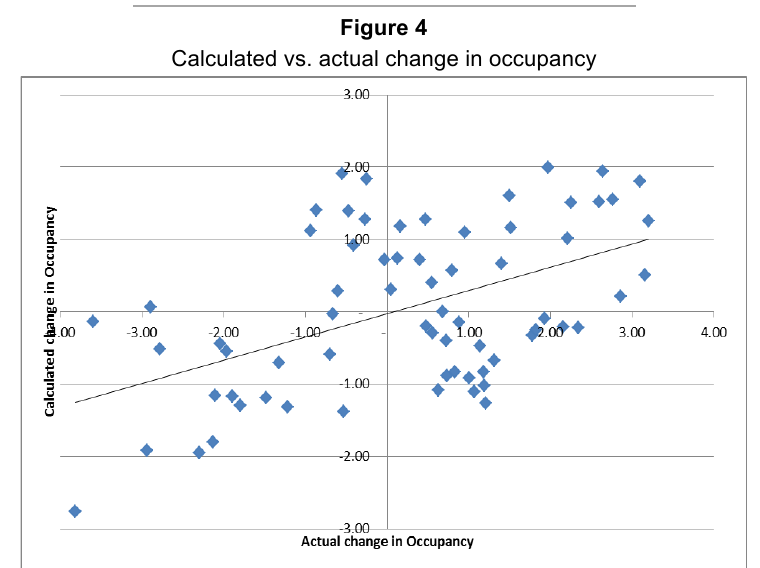
Calculated vs. actual change in occupancy